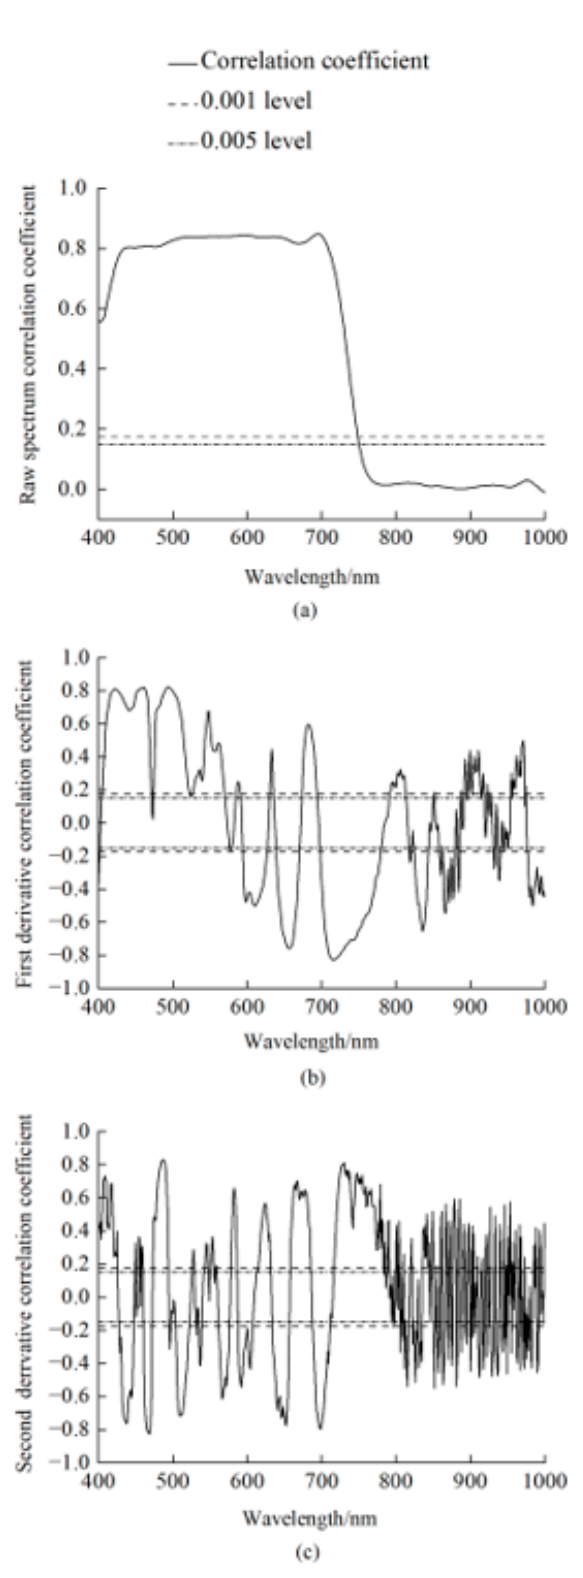
Figure 4. ( a ) The correlation coefficient of the raw spectrum with Anth; ( b ) the correlation coefficient of the first derivative spectrum with Anth; ( c ) the correlation coefficient of the second derivative spectrum with Anth.